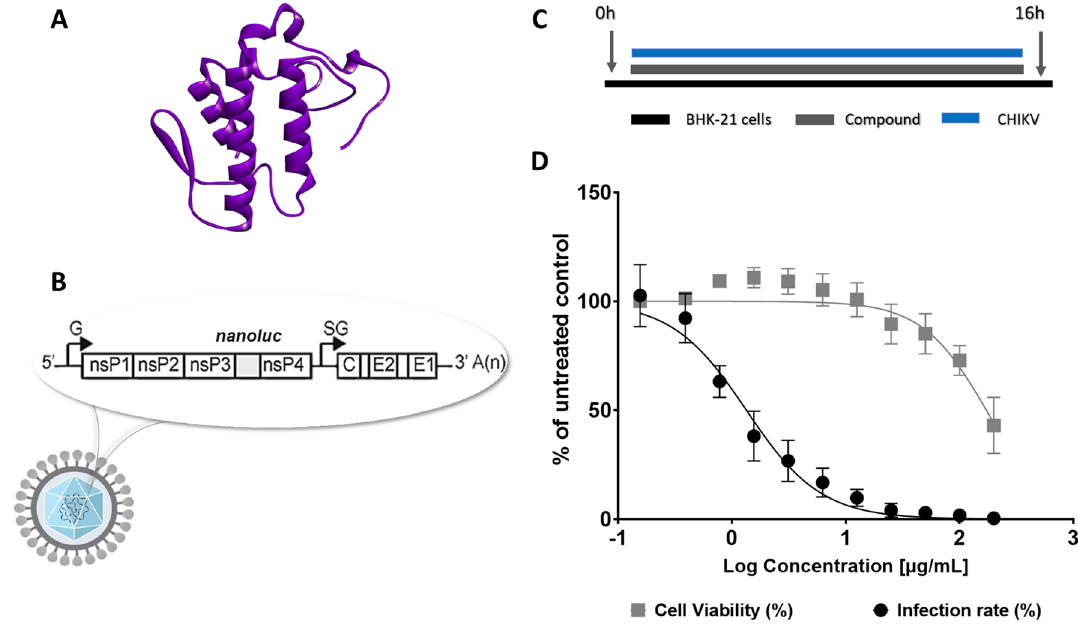
Figure 1. The activity of Phospholipase A2 CB (PLA2 CB ) against CHIKV infection. ( A ) Phospholipase A2 CB protein structure (PDB: 3R0L). ( B ) Schematic representation of CHIKV -nanoluc genome. ( C ) Schematic description of infectivity assay. ( D ) BHK-21 cells were treated with concentrations of PLA2 CB ranging from 0.195 to 200 µg/mL. CHIKV replication was quantified by measuring of nanoluciferase activity (indicated by black dot) and cellular viability was measured using an MTT assay (indicated by grey square). The mean values of three independent experiments each measured in triplicate including the standard deviation are shown. All images were generated using GraphPad Prism 8 and GIMP 2.10.20 (www. gimp.